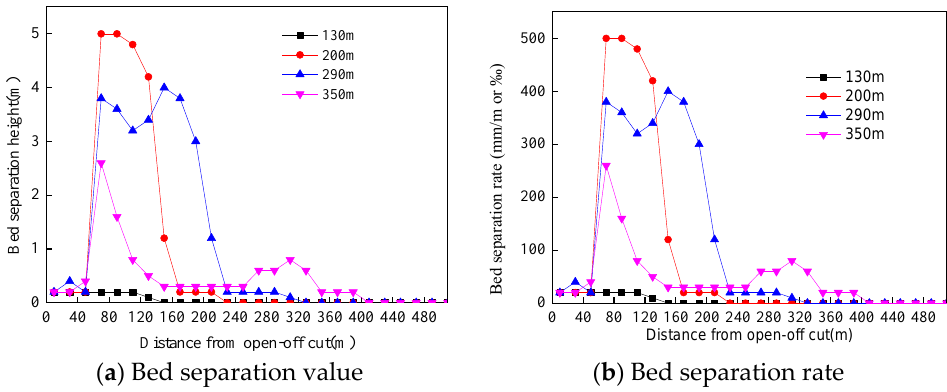
Figure 7. Dynamic evolution of the bed separation between the monitoring lines #3 and #4.